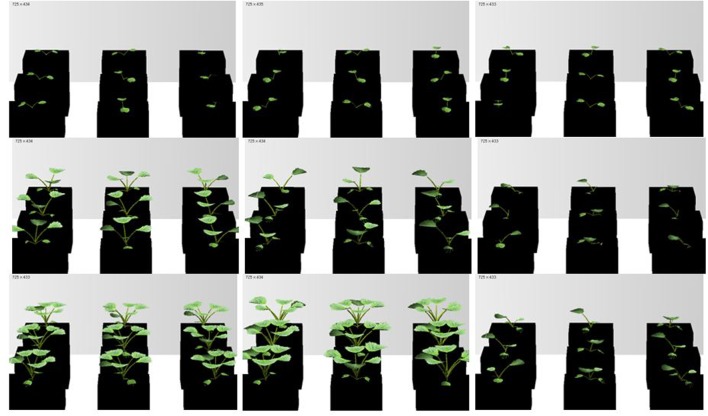
Simulated rapeseed seedlings at three temperature treatments: H, M, and L temperature (left to right) and at different times after transfer (days after treatment, dat) to the chamber: 2, 13, and 20 dat (top to bottom).